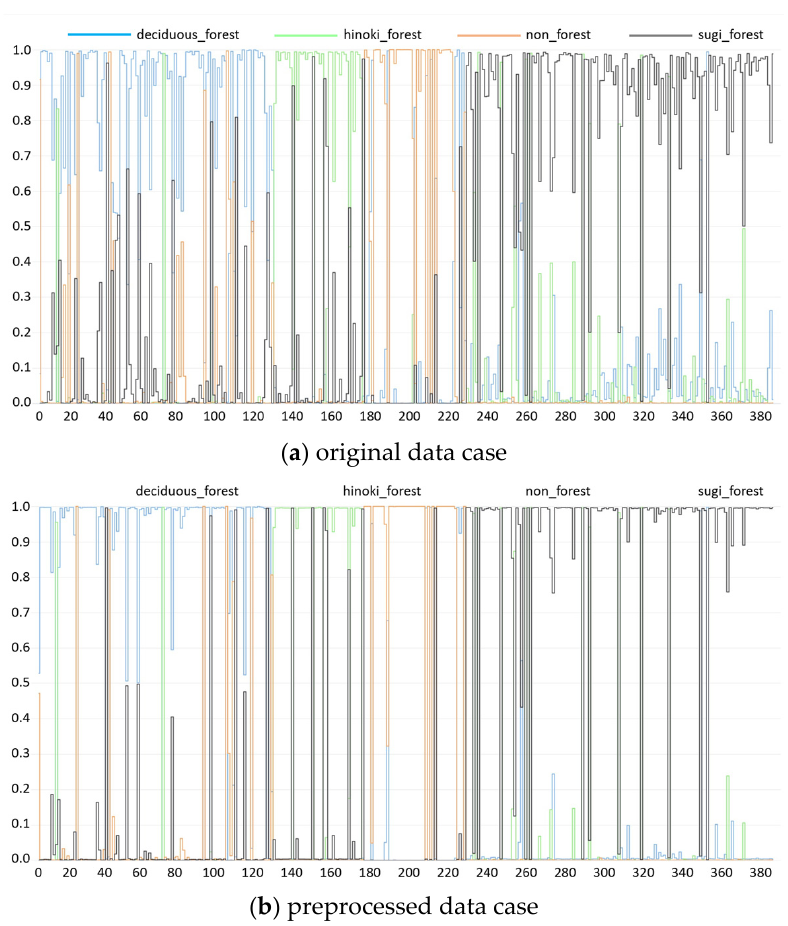
Figure 5. Illustrations of the three forest types from the ground view.